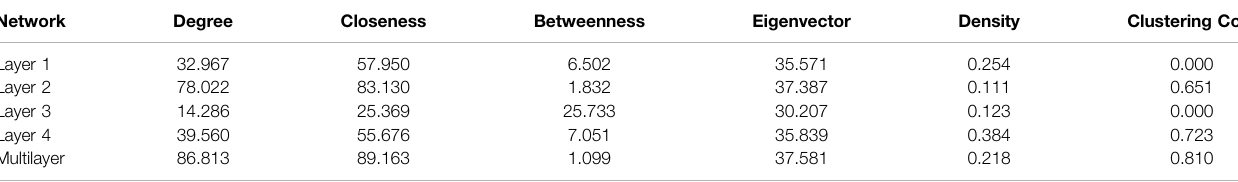
TABLE 6 | Characteristic description of multilayer networks. Network